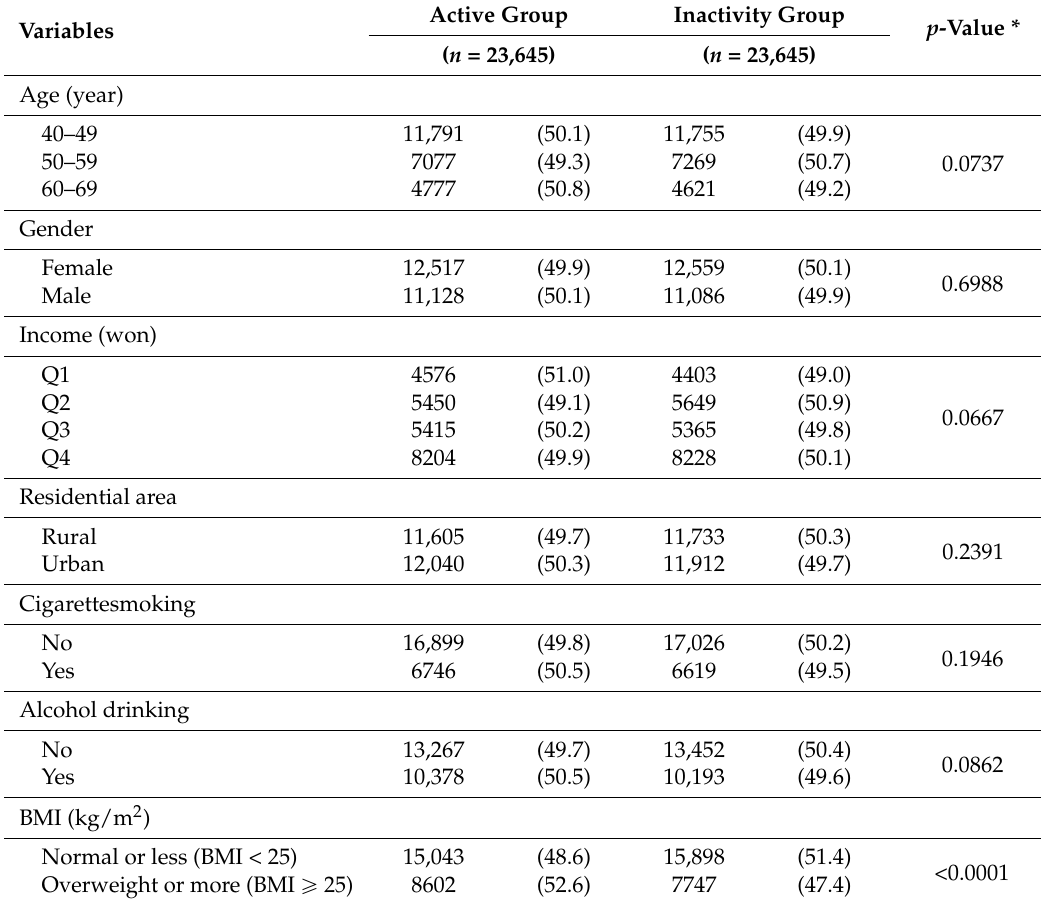
Table 1. Baseline characteristics of the study population: physical active groups and physically inactive groups (2002–2004) unit: n